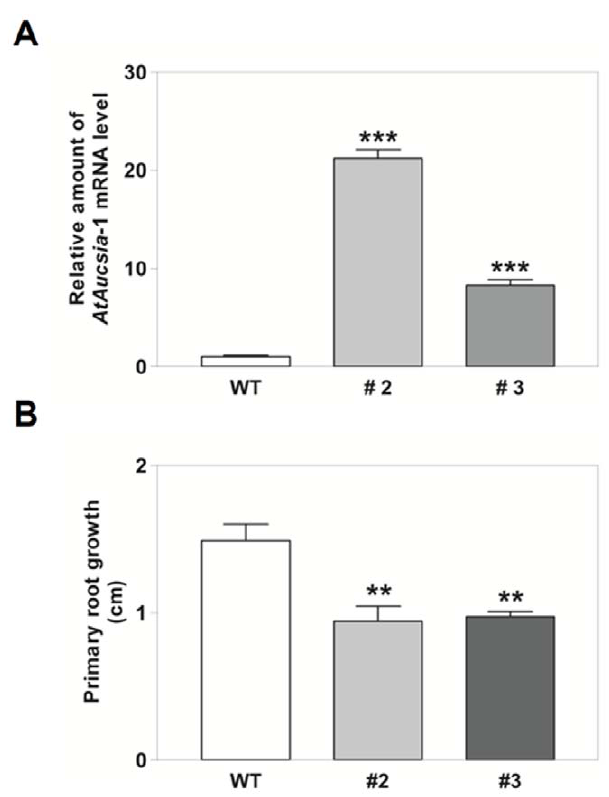
Figure 5. Overexpression of AtAucsia -1 gene in A.thaliana . (A) Quantitative real-time PCR analysis of AtAucsia -1 gene expression in wild-type, AtAucsia-1OX # 2 and AtAucsia-1OX # 3 lines transformed with Pro35S::AtAucsia-1 construct. Mean expression levels 6 SE are shown. (B) Primary root growth of wild-type and AtAucsia-1OX # 2 and AtAucsia-1OX # 3 lines evaluated in 5 days old seedlings. Mean expression levels 6 SE are reported, (n=3) 15–20 seedlings per replicate. Data reported were analyzed by Student’s t -test. **P , 0.01; ***P , 0.001 versus wild-type seedlings.